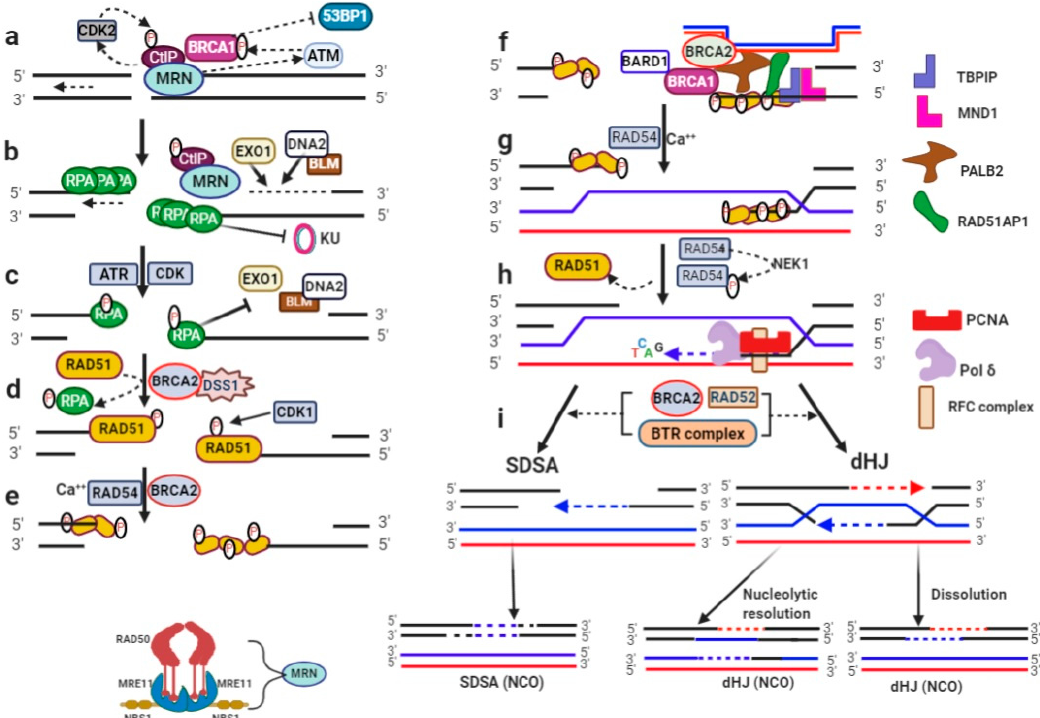
Figure 2. DSB repair via HR: ( a ) MRN complex binding with DSB ends, phosphorylation of CtIP and BRCA1 to activate MRN complex and inhibiting 53BP1; ( b ) long-range resection initiation via the EXO1 or BLM-DNA2 pathways, RPA covering of 3 ′ -ssDNA tails, and KU inhibition; ( c ) RPA phosphorylation (pRPA) by ATR and CDK to negatively regulate resection; ( d ) replacement of pRPA with RAD51 mediated by BRCA2–DSS1 complex; ( e ) RAD51-nucleofilament formation; ( f ) RAD51AP1 and the TBPIP–MND1 complex stabilize RAD51-NF, PALB2 forms a complex with BRCA1, BRCA2, and DNA, and the BRAD1–BRCA1 complex in homology searching; ( g ) synaptic complex and D-loop formation; ( h ) DNA synthesis and D-loop extension; ( i ) D-loop dissociation and annealing via SDSA, in which newly synthesized DNA anneals with ssDNA tails or dHJ for- mation and dissolution into non-crossover products.